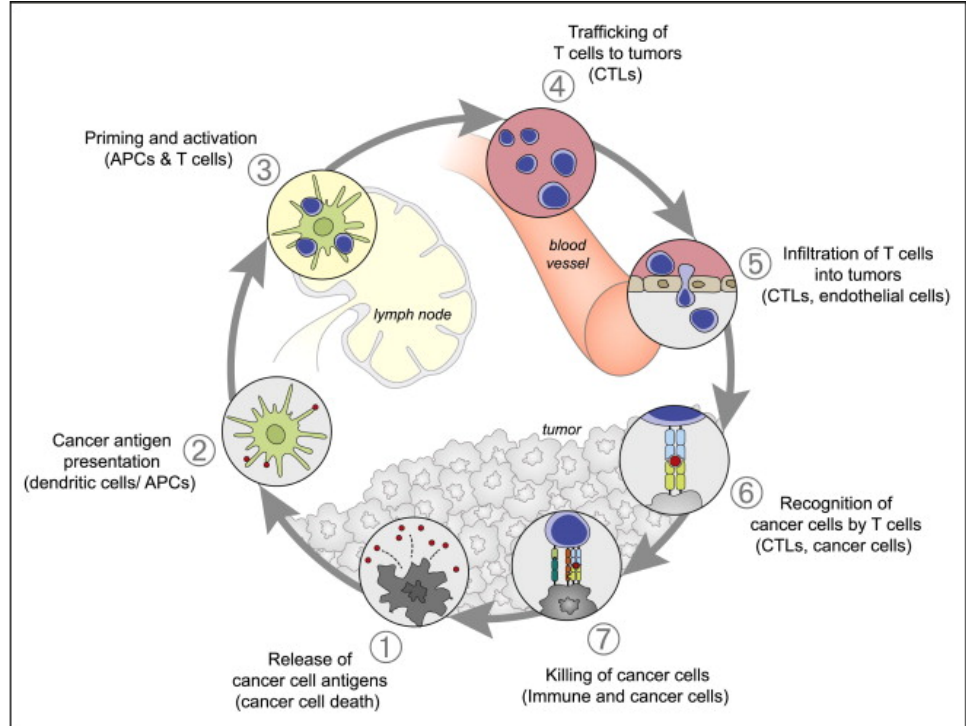
Figure 4. The Cancer-Immunity Cycle. The generation of an immune response to cancer is cyclical and can be divided into seven major steps. It starts from release of tumor-associated antigen and ends with the killing of cancer cells by T cells. Abbreviations: APCs, antigen presenting cells; CTLs, cytotoxic T lymphocytes. Reprinted with permission from Ref. [112]. Copyright 2021, Elsevier Inc.